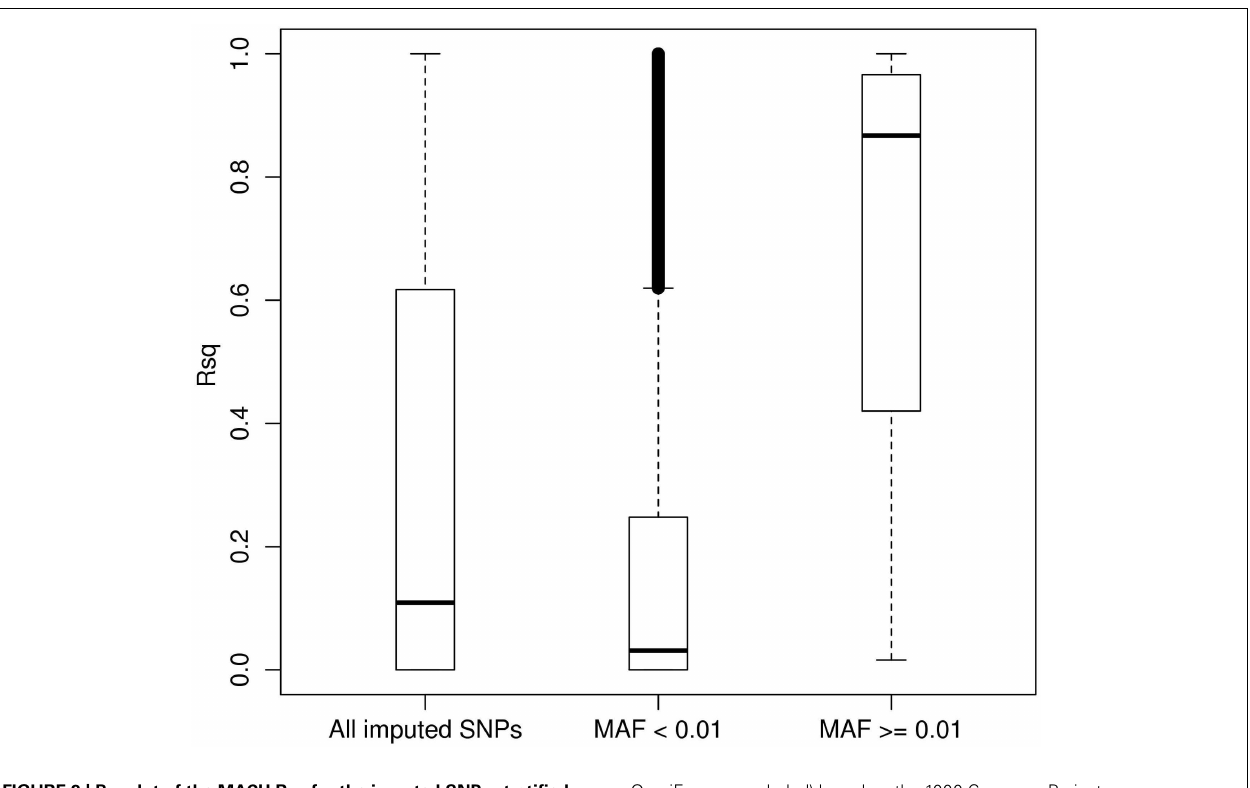
FIGURE 3 | Boxplot of the MACH Rsq for the imputed SNPs stratified by the minor allele frequency. Boxplot of the MACH Rsq for 485,313 imputed SNPs on chromosome 22 (with all typed SNPs by the Illumina